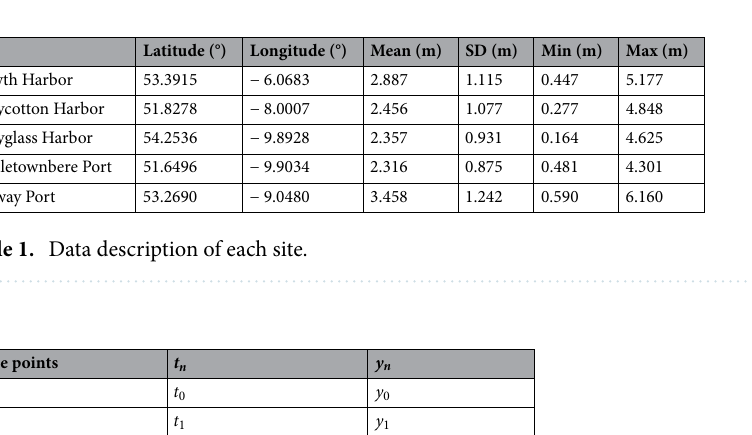
Figure 1. Location distribution of each site and partial tidal observation sequences.